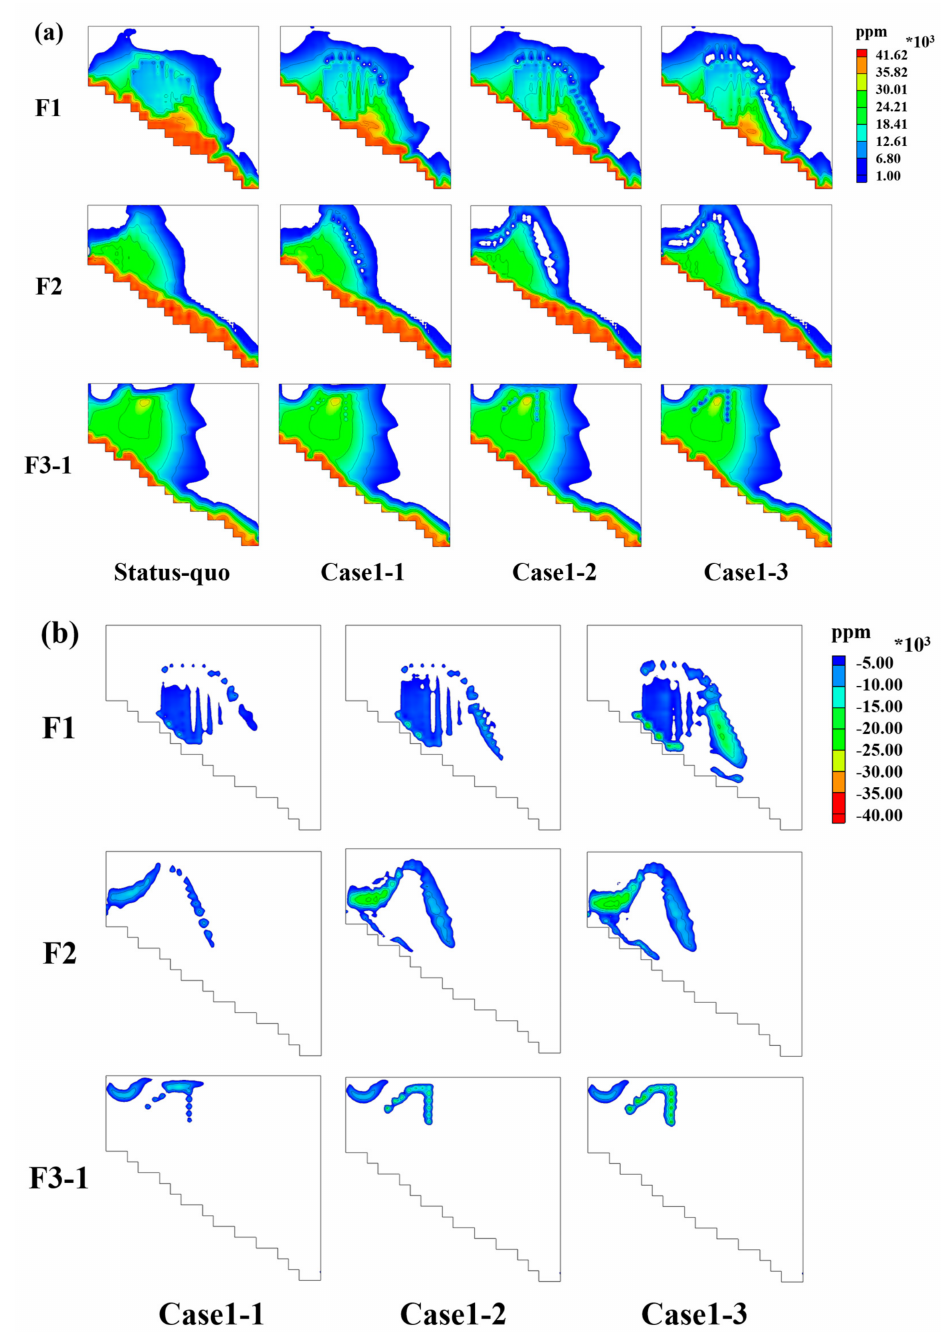
Figure 11. The optimized results in management Scenario #2: ( a ) the simulated TDS concentrations after 20-year of remediation using identified optimal injection strategy #2; and ( b ) the difference of concentrations between 20-year of remediation and the initial